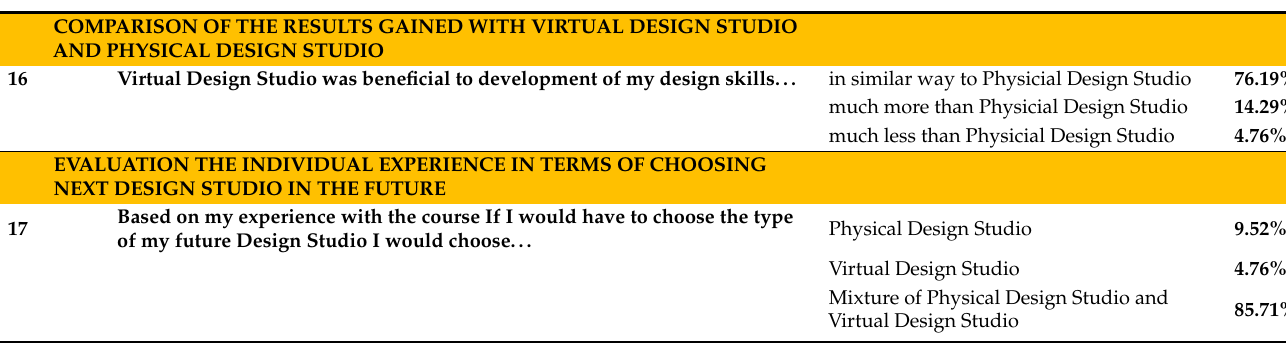
Table 3. Results of the survey—part 2. Questions 16–17 with 3 optional